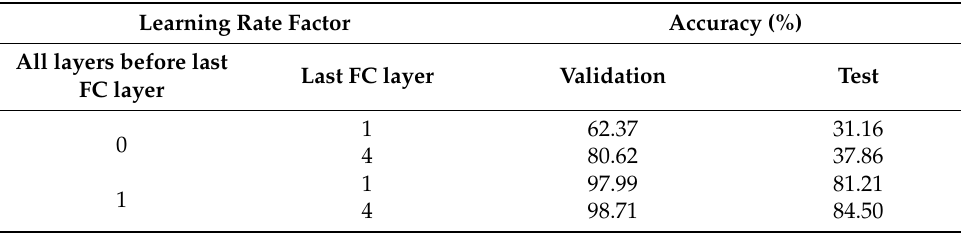
Table 6. Performance comparison of freezing (learning rate factor equals 0) and unfreezing (learning rate factor equals 1 and 4) the layers on transfer learning of DenseNet-201 model using UFPR dataset.